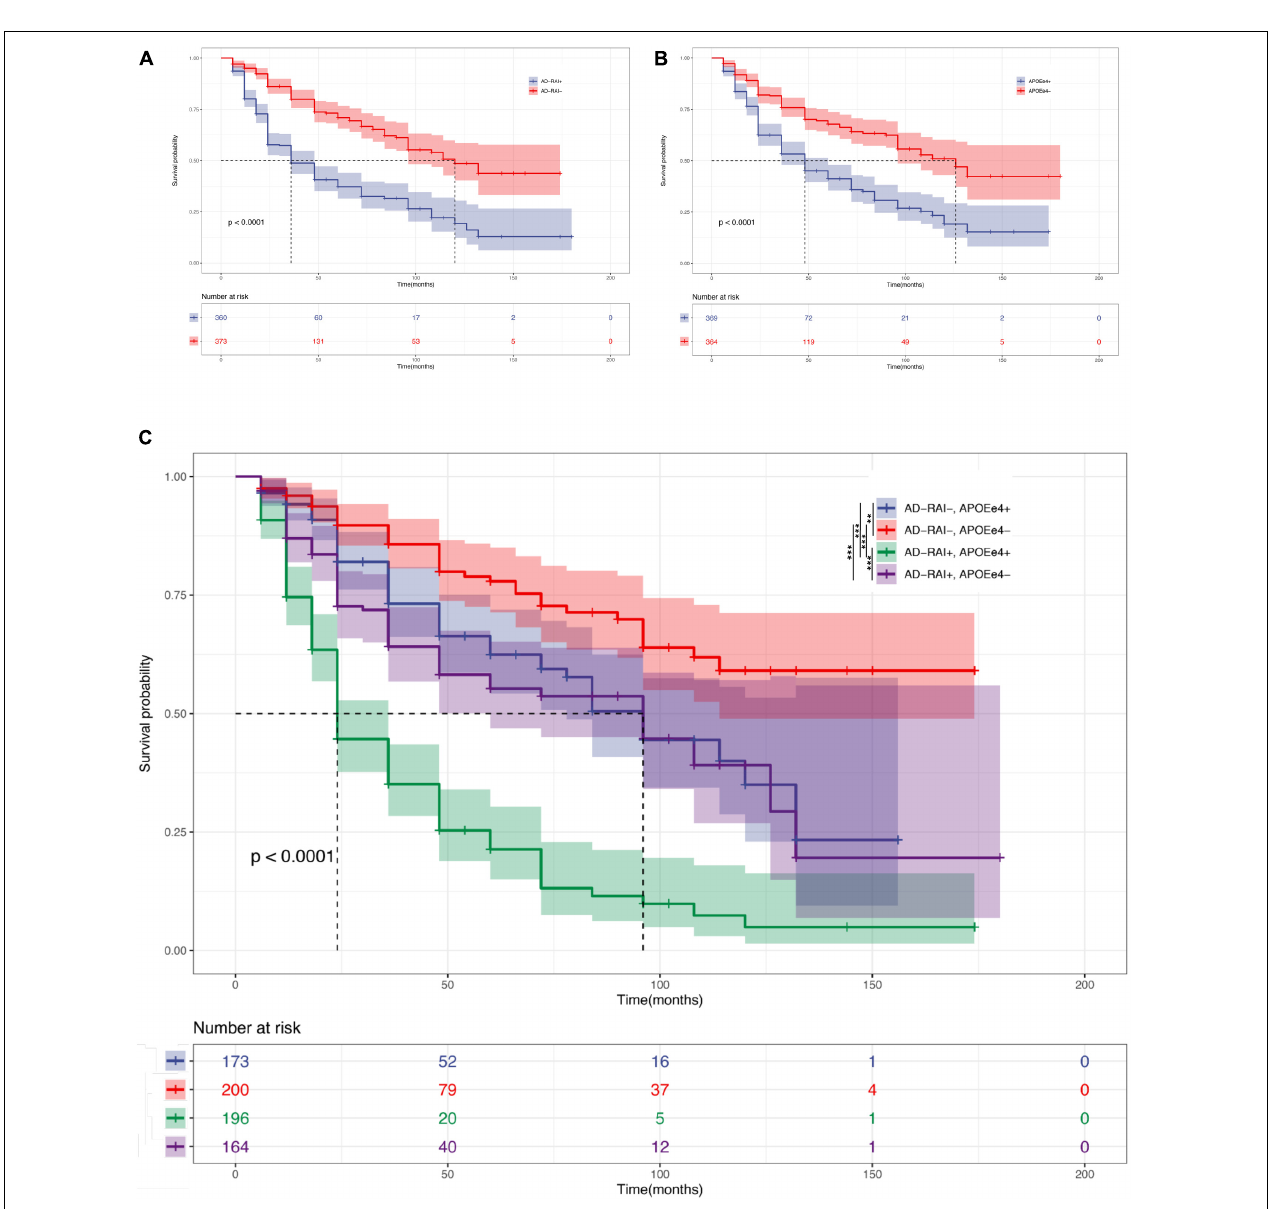
FIGURE 3 | AD-RAI and APOE- ε 4 as predictors in MCI. Kaplan–Meier curves showing that AD-RAI+ (A) and APOE- ε 4+ (B) increased the risk of MCI progression. AD-RAI+ together with APOE- ε 4+ reached the highest speed of AD conversion (C) . * P < 0.05; ** P < 0.01; *** P <